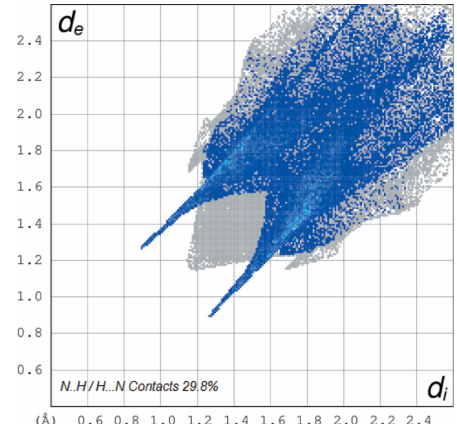
Figure 4 The two-dimensional fingerprint plot for the title compound depicting the contribution of the N (cid:3)(cid:3)(cid:3) H